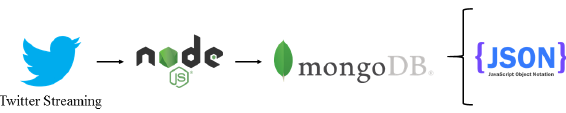
Figure 1. Software architecture of the Twitter data collector